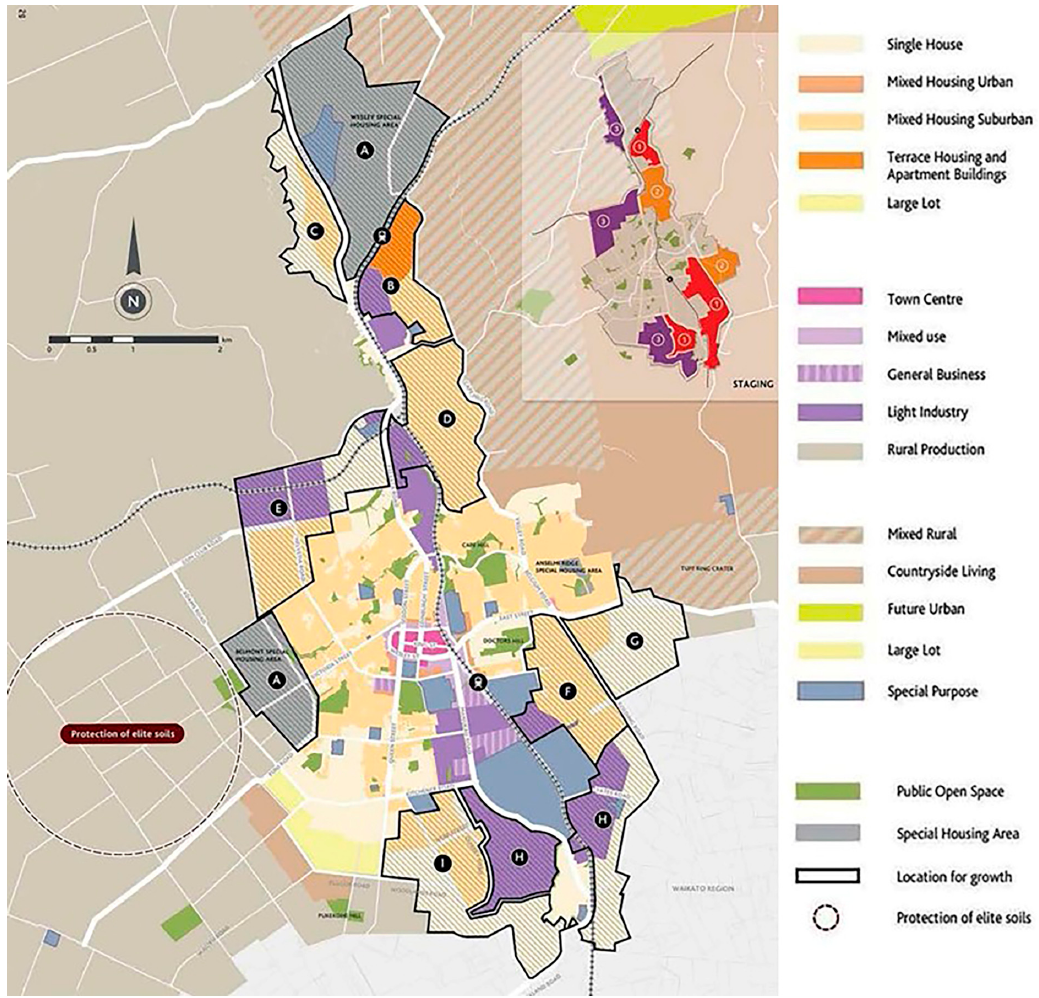
Figure 5. Map of Pukekohe and its proposed land uses (Auckland Council. Pukekohe-Paerata Structure Plan Process. September 2017. Copyright © Auckland Council, Auckland. New Zealand).